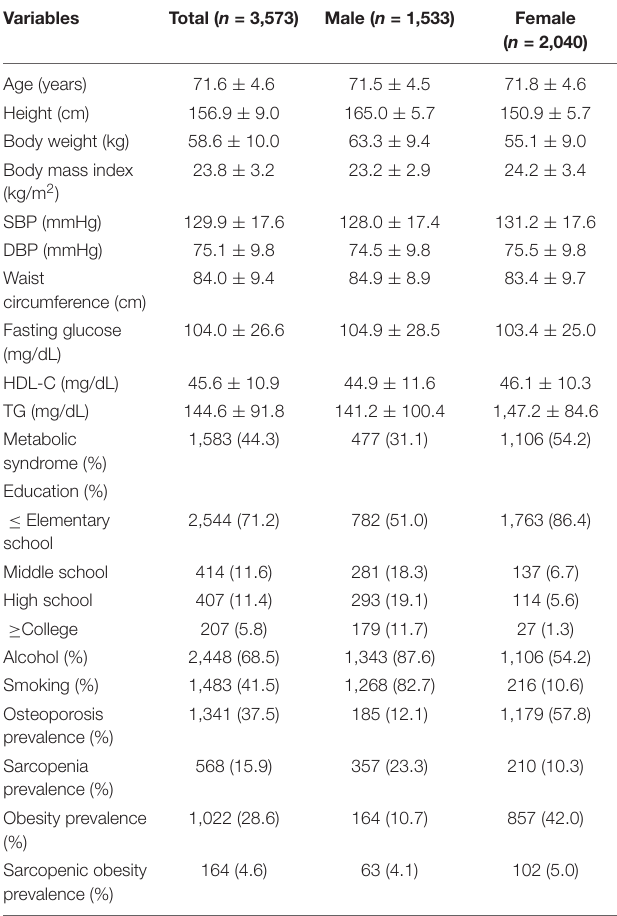
TABLE 1 | Baseline characteristics of the